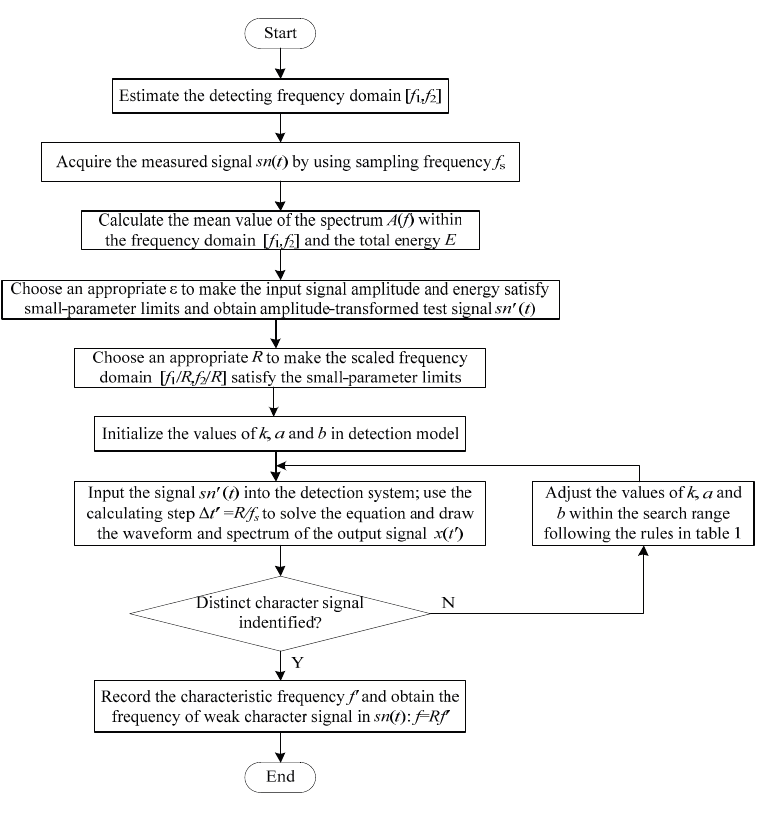
Figure 5. The flowchart of the proposed GPASR